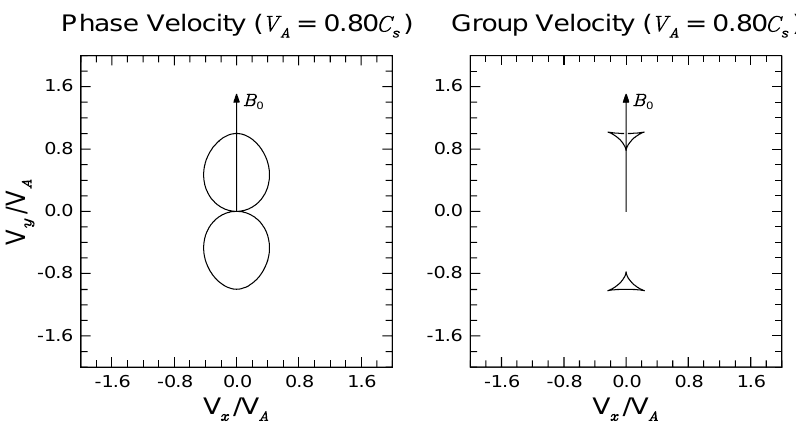
Fig. 3. The slow mode wave phase and group velocities relative to the background magnetic field for V A = 0 . 8C s . Here V A is the Alfv´en speed, C s is the sound speed, and B 0 is the background magnetic field. Although the phase velocity can be in any direction except perpendicular to the background magnetic field, the group velocity can only be within a small angle away from the background magnetic